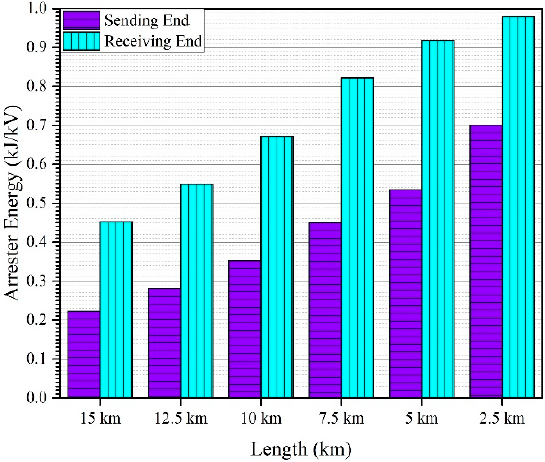
Figure 25. Surge arrester energy according to the length of the cable.